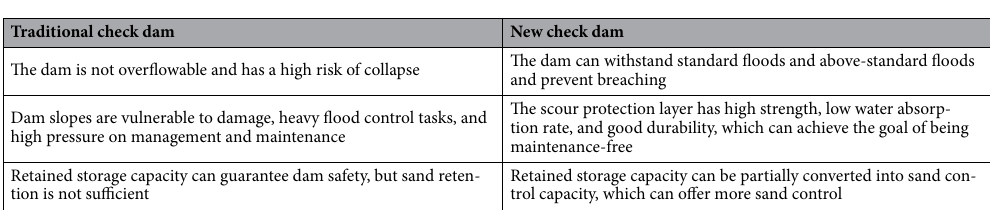
Table 1. Comparison of design concepts and ideas for check